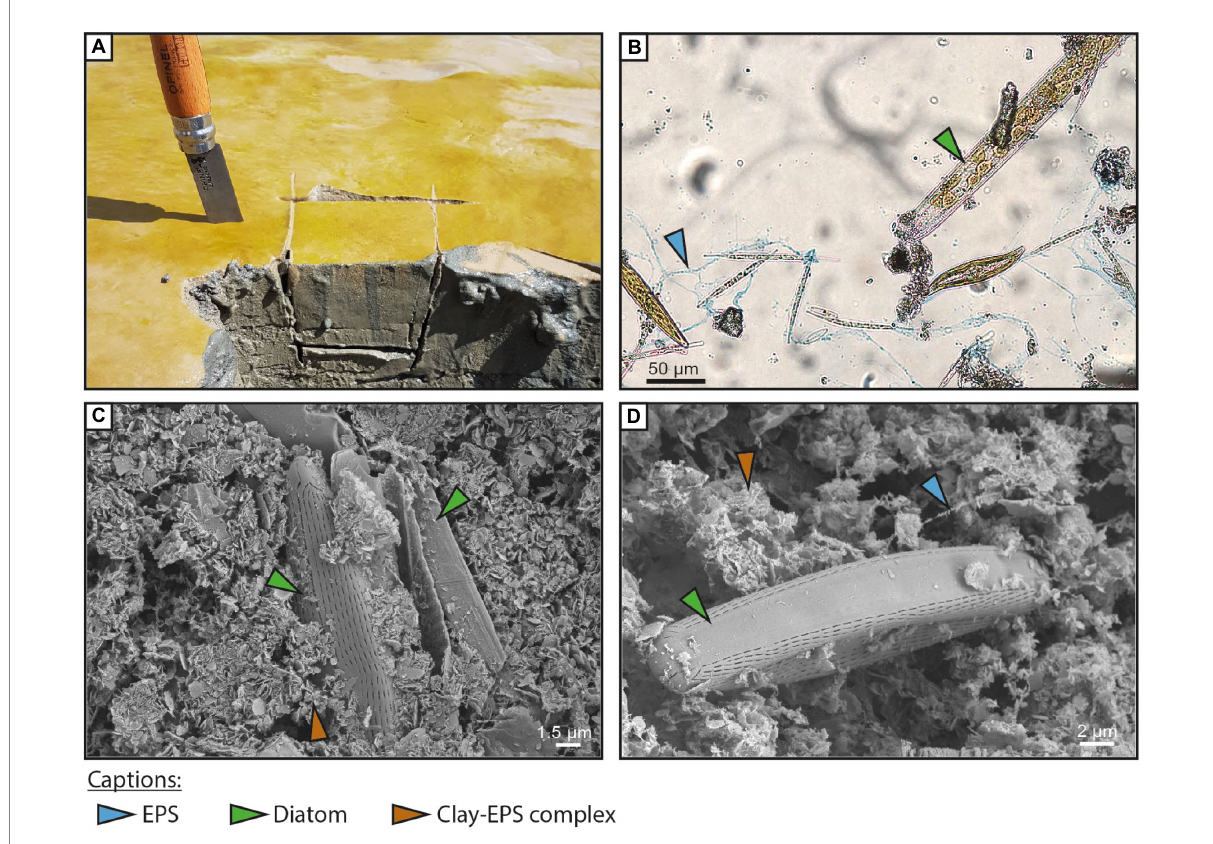
FIGURE 3 Field and microscope observations of the surface biofilm. Exopolymeric substances (blue arrow), diatoms (green arrow), and clay-EPS complexes (brown arrow). (A) Field picture of the diatom biofilm at the surface of the sediment. The biofilm forms a millimeter-thick golden lamina at the surface of the sediment. (B) Transmitted light microscopic image of the biofilm colored with Alcian Blue. The blue coloration shows acidic EPS fibers surrounding diatoms. Three diatom genera were identified: Nitzschia sp., Pleurosigma sp., and Navicula sp. (C) Cryo-SEM picture of the surface biofilm showing two diatoms surrounded by a mixture of clay and EPSs. EPS fibers form an organo-mineral complex with clay platelets. (D) Cryo-SEM picture of a diatom. Cryofixation preserves the 3D structure of EPSs and allows the observation of very thin EPS fibers. The clay-EPS complex displays a typical alveolar